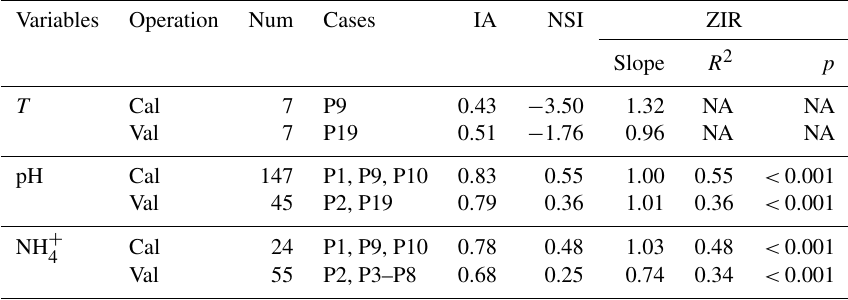
Table 4. Statistical indices for evaluating the performance of the CNMM–DNDC in simulating the daily temperature ( T ), pH, and ammonium concentration (NH + ) in floodwater for the calibration (Cal) and validation (Val) cases. 4 Variables Operation